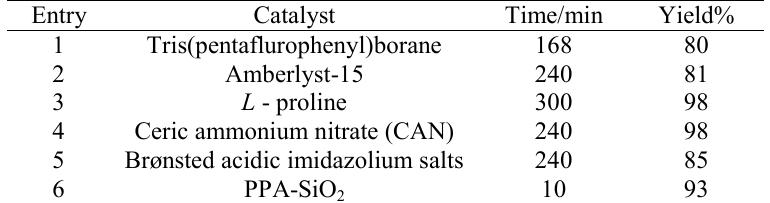
Table 3. Comparison results of PPA-SiO with tris(pentaflurophenyl)borane 12 , Amberlyst- 2 15 10 , proline 14 , ceric ammonium nitrate (CAN) 19 and brønsted acidic imidazolium salts 16 as catalysts in the reaction of benzaldehyde, dimedone, and ammonium